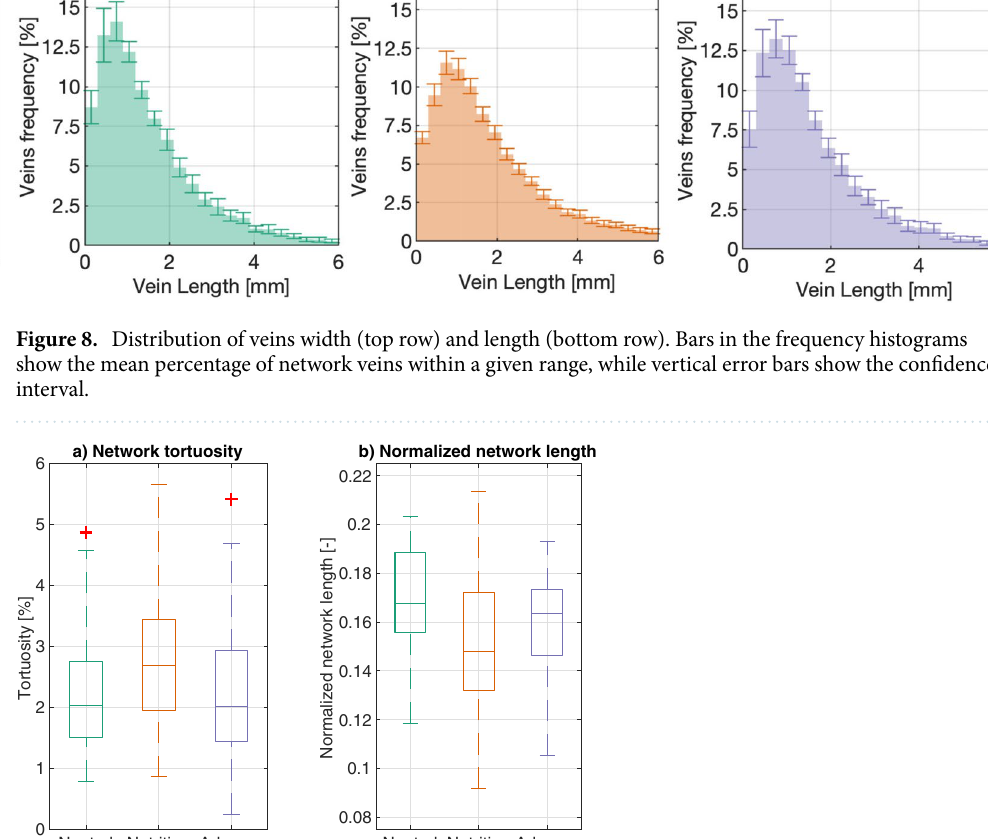
(MST) and a maximally connected (DT) networks respectively. Results from Fig. 12 show that the networks in the neutral and adverse environments are similar in terms of resiliency, while the networks in the nutritive substrate are the least resilient (Tables S24, S25, S26, Fig. 12). The fact that networks in a nutritive environment are the most centralized and the least resilient suggest that they depend heavily on certain edges which sustain the connectivity of the network. On the contrary, the exploratory behaviour of slime molds in neutral or adverse conditions yields networks that are less centralized and more resilient, e.g. more capable to overcome accidental disconnections. Moreover, the relationships between network cost (normalized network length) and resiliency (normalized fault tolerance) and the edges importance distribution (mean drag betweenness) show that the normalized fault tolerance is positively correlated with the normalized network length (Table S27, Fig. 13a) whereas the mean drag